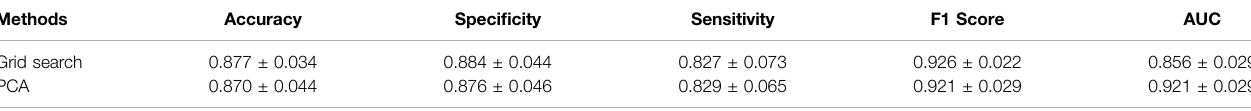
TABLE 5 | Comparison of the classi fi cation effects of two different feature selection methods for the VCG-only model